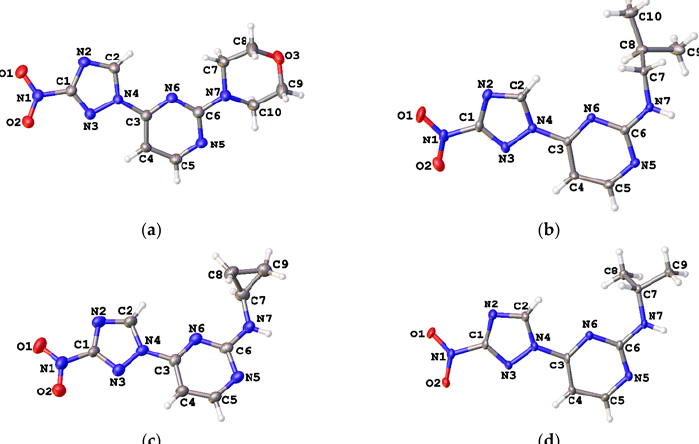
Figure 4. Single-crystal X-ray structures for compound 2h ( a , CCDC 1582450), 2k ( b , CCDC 1582440), 2n ( c , CCDC 1582442) and 2o ( d , CCDC 1582439); thermal ellipsoids are shown at 50% probability.